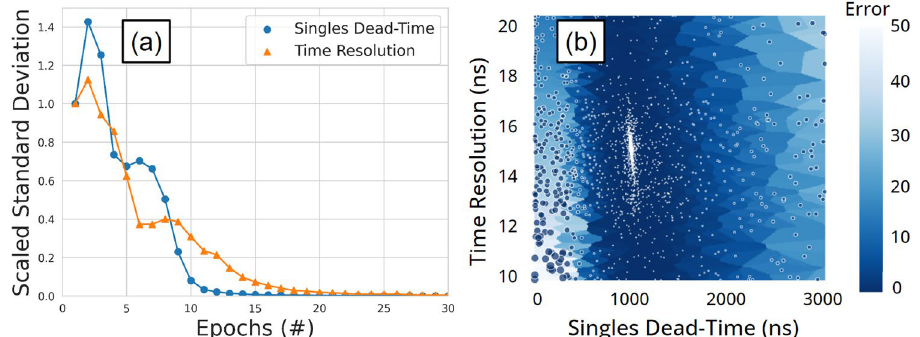
Figure 11. An example of an optimised GATE model with two free parameters. ( a ) The scaled standard deviation for each parameter over several epochs of simulations ( b ) a Voronoi diagram of the parameter combinations shows the solution converges to the optimal parameters. Each point is a candidate solution and the larger the point or lighter blue the Voronoi plot the higher the error in the cost-function